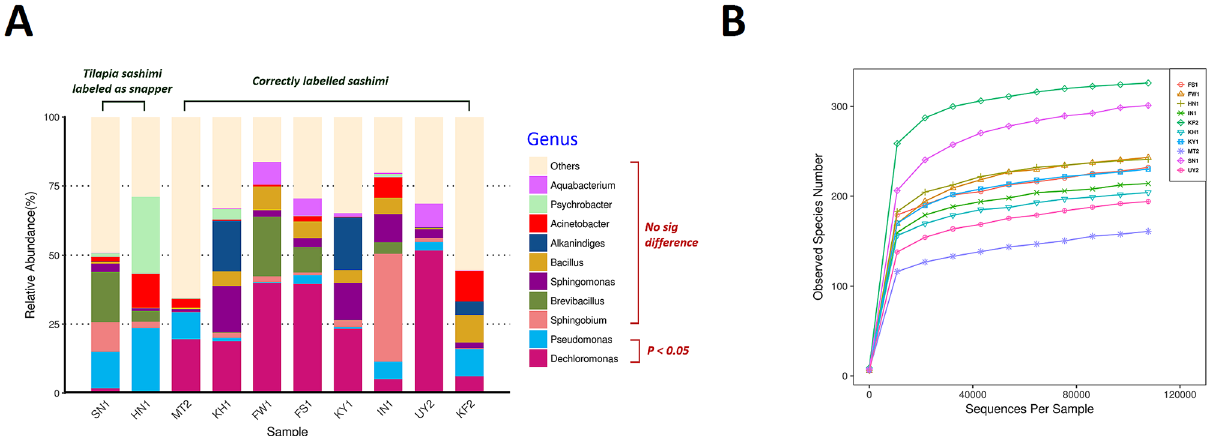
Figure 4. The microbiome analysis of tilapia and commonly-consumed sashimi samples in restaurants. ( A ) The relative abundance of microbiota in 2 tilapia sashimi mislabeled as snapper (SN1, HN1: Oreochromis niloticus) and 8 commonly-consumed and correctly labeled sashimi (MT2: Thunnus thynnus; KH1: Atheresthes stomias; FW1: Makaira nigricans; FS1: Salmo salar; KY1: Seriola dumerili; IN1: Pagrus major; UY2: Seriola quinqueradiata; KH2: Cololabis saira). Significant difference of relative abundance of Pseudomonas and Dechloromonas were found between tilapia and commonly-consumed sashimi samples (both P = 0.044). ( B ) Rarefaction curves of the 10 samples in the microbiome sequencing saturation